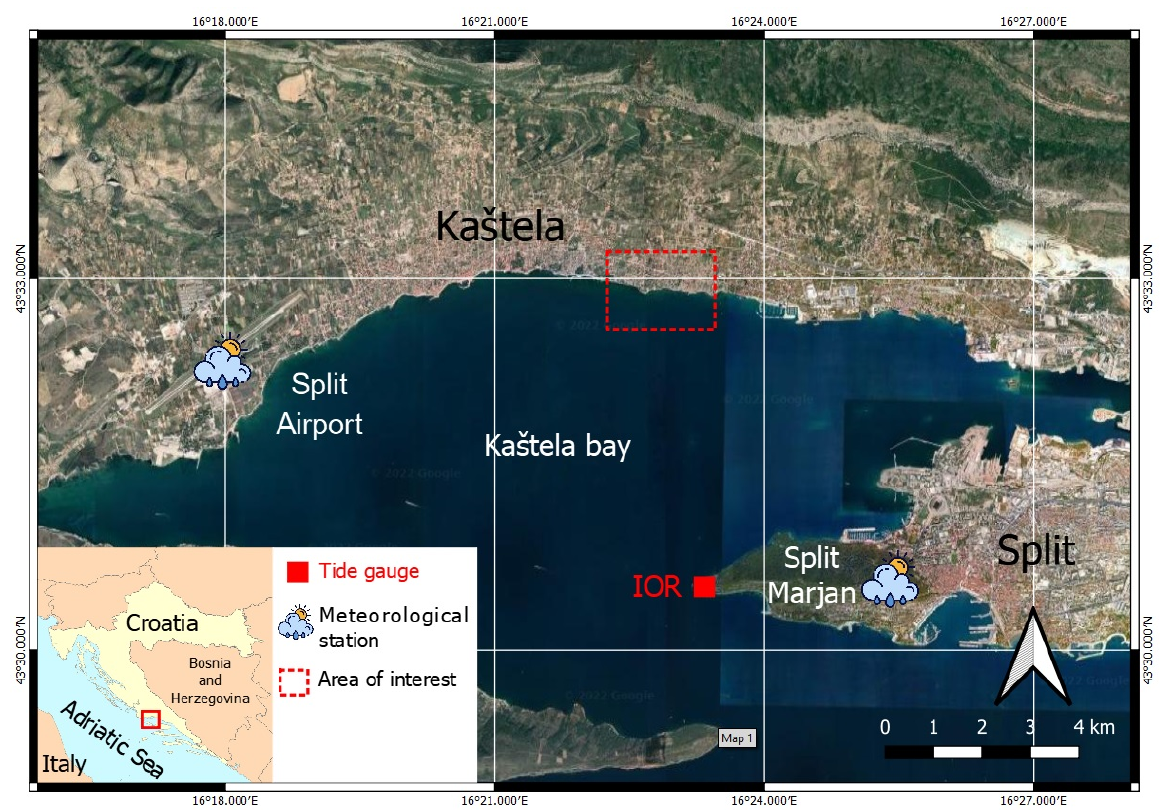
Figure 3. Location of the study area with the definition of the tidal gauge and meteorological stations (IOR—Institute of Oceanography and Fisheries).